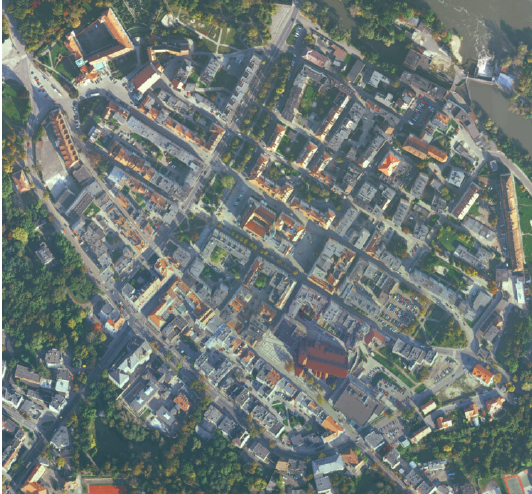
Figure 4a. An overview of the tested area.